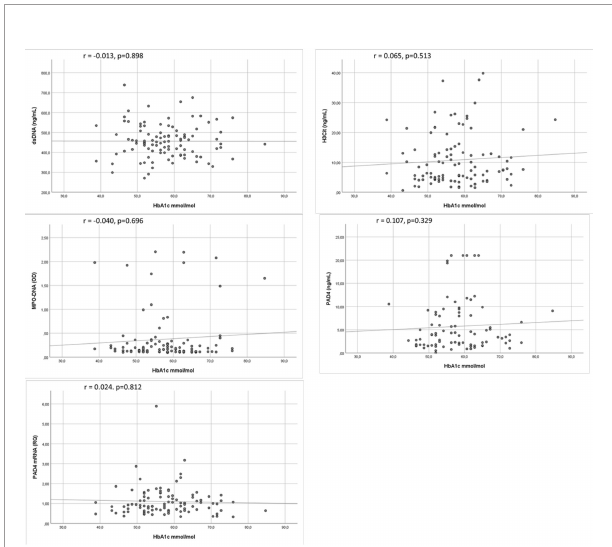
FIGURE 1 | NETs marker levels according to presence of T1DM. Boxplot- The line inside the boxes represent the median, the box boundaries the 25 th and 75 th percentiles, while the lower and upper lines represent the 10 th and 90 th percentiles. T1DM, type 1 diabetes mellitus; dsDNA, double-stranded deoxyribonucleic acid; MPO-DNA, myeloperoxidase-DNA; H3Cit, citrullinated histone 3; PAD4, peptidylarginine deiminase 4.